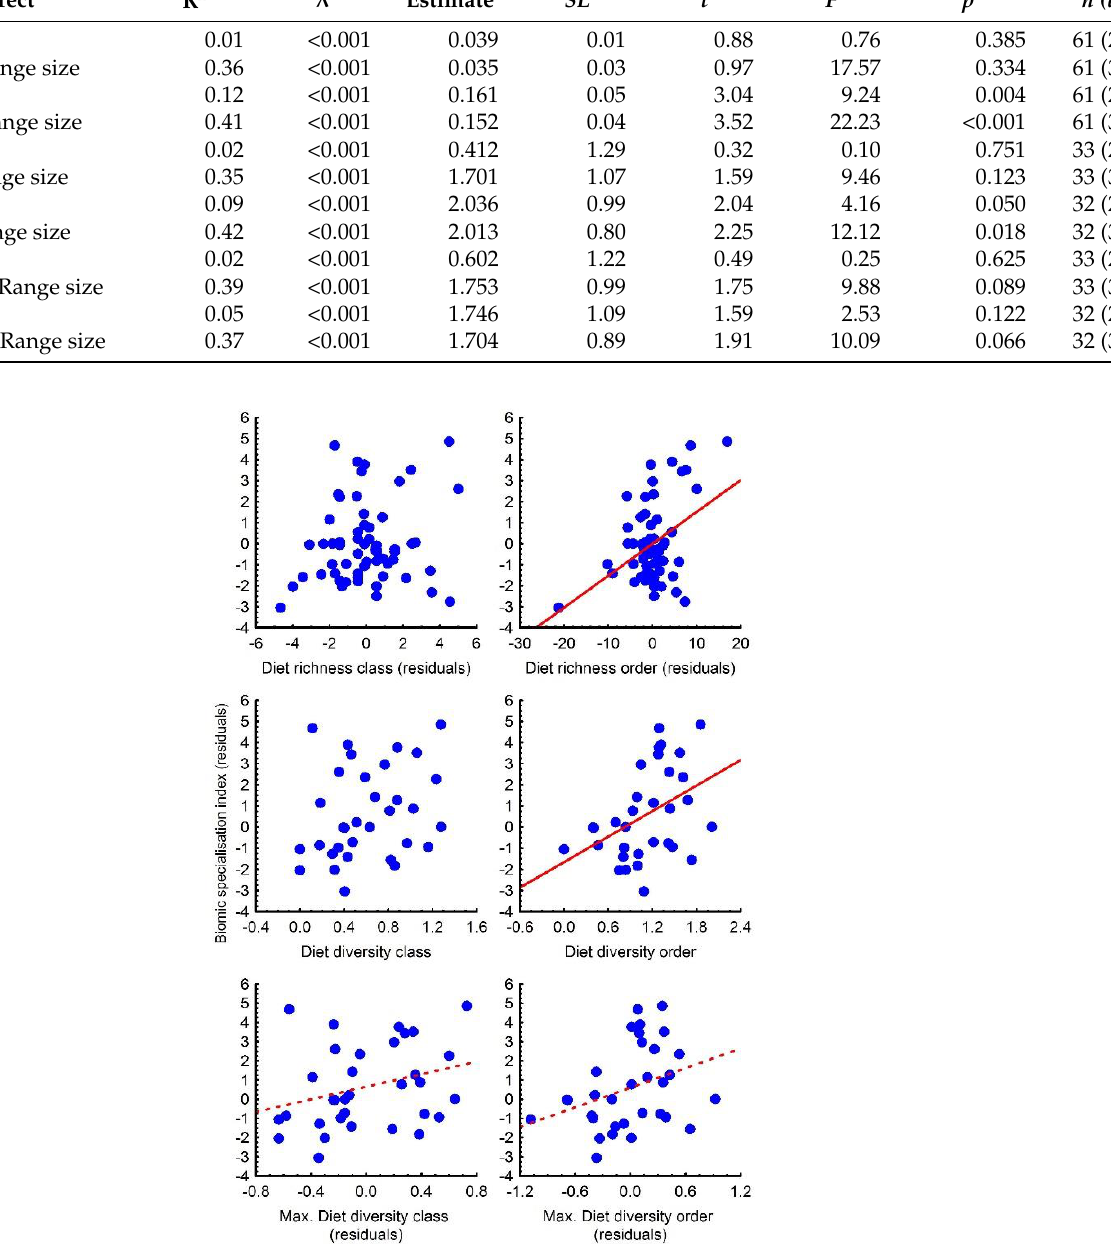
Figure 3. Relationships between biomic specialisation index (BSI) controlled for range size (residuals) of Falconidae species and the different diet indexes of trophic breadth (richness, diversity and maximum diversity) estimated at class and order taxonomic ranks. Diet richness and maximum diet diversity were detrended (residuals) with respect the number of studied populations. Dashed lines represent marginally significant correlation ( p values between 0.06 and 0.09).